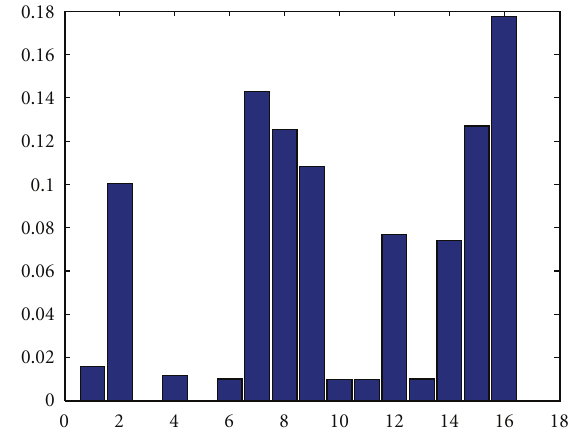
Figure 12: Histogram of parasitic switching combinations (ULA):